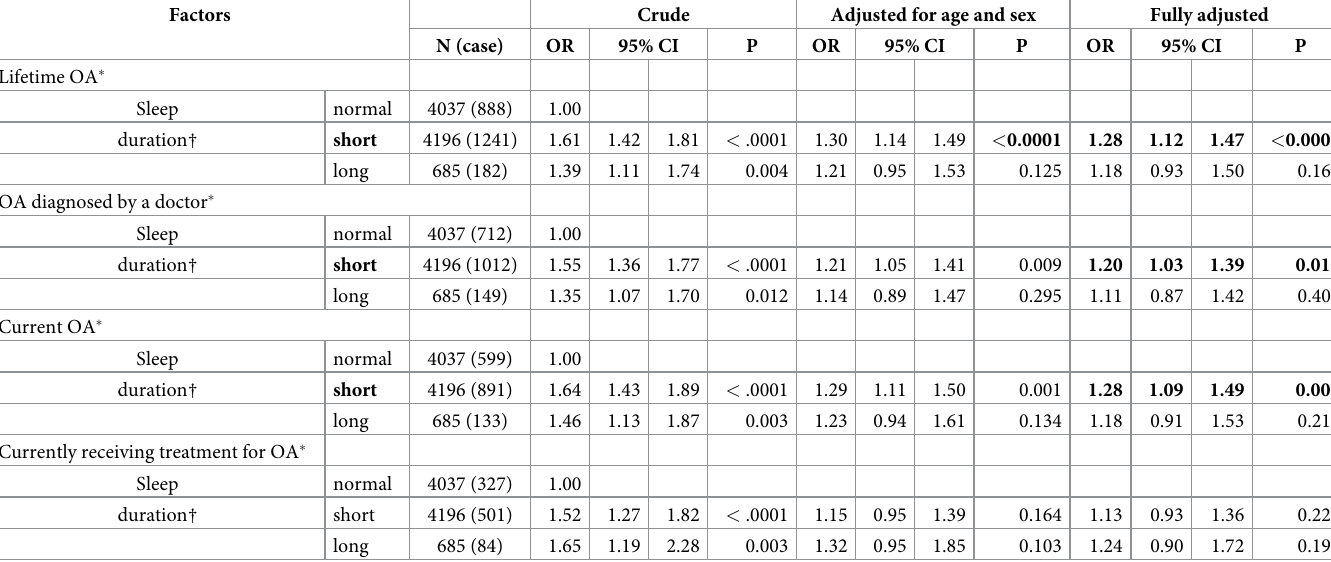
Table 3. Relationship between sleep duration and OA-related questionnaire